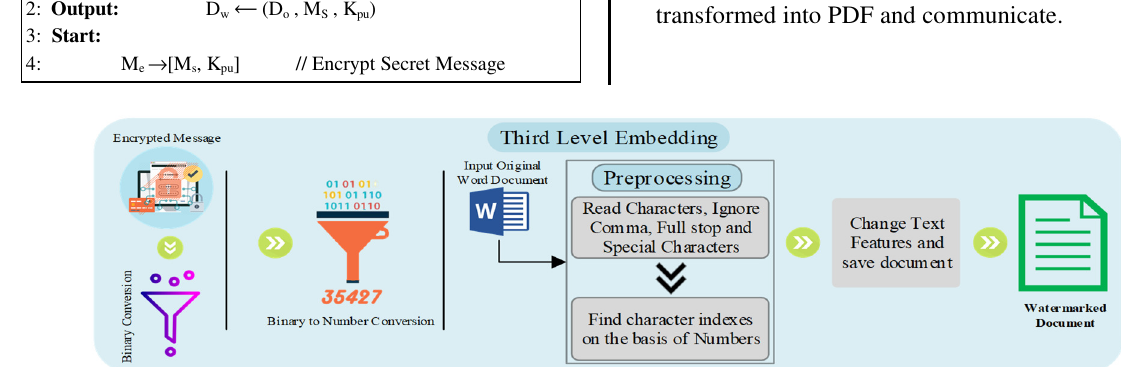
Fig. 4. Third Level Digital Watermark